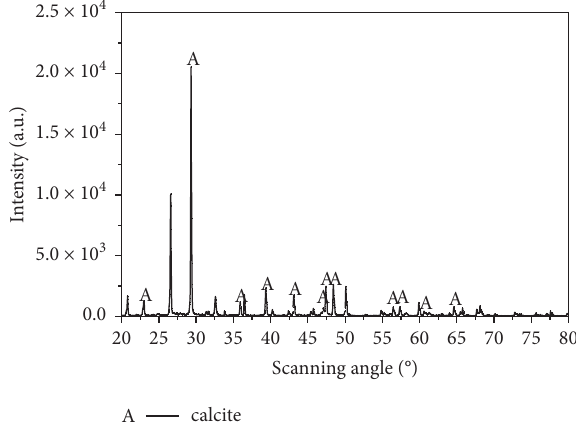
Figure 3: The analysis of X-ray diffraction bacterial